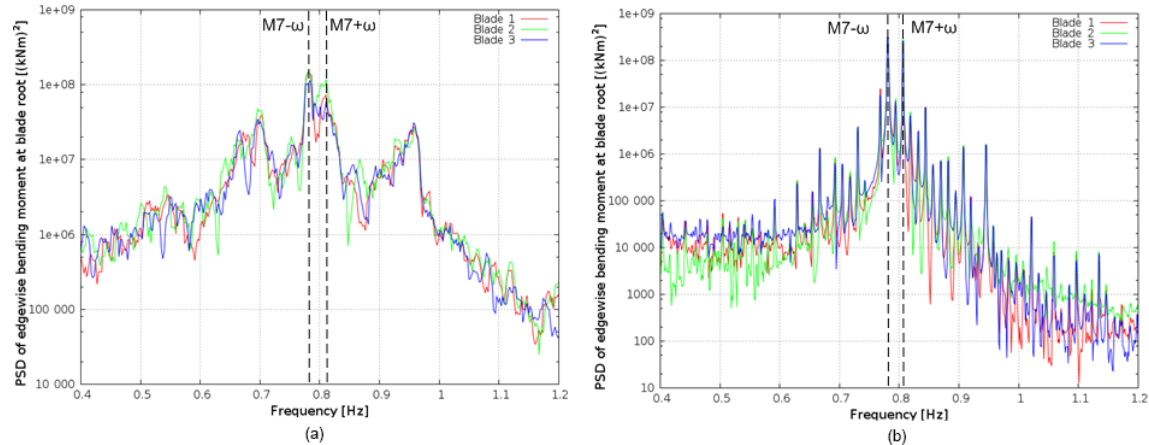
Figure 21. PSD of the edgewise bending moment at the blade root; U = 42 . 5ms − 1 and yaw = 30 ◦ . (a) Turbulent inflow (focus plot) and (b) uniform inflow (focus plot).